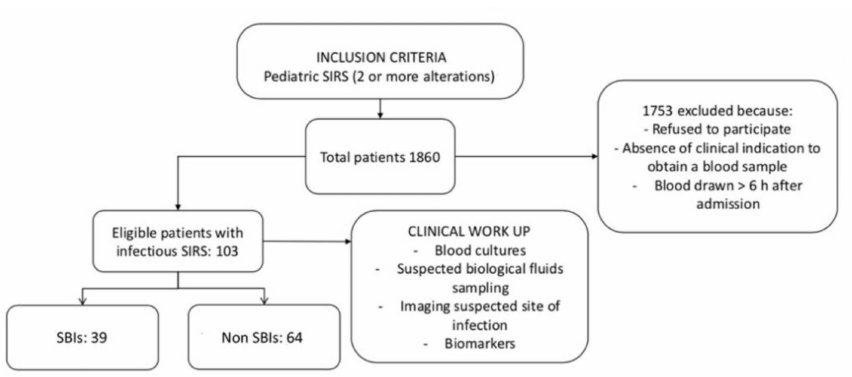
Figure 1. Study design flow